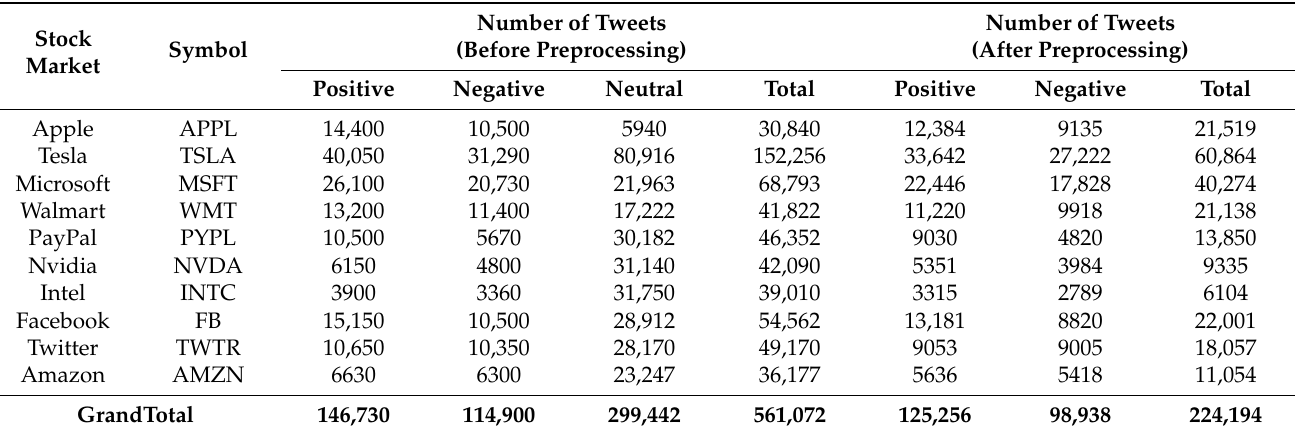
Table 6. Details of data directly extracted from